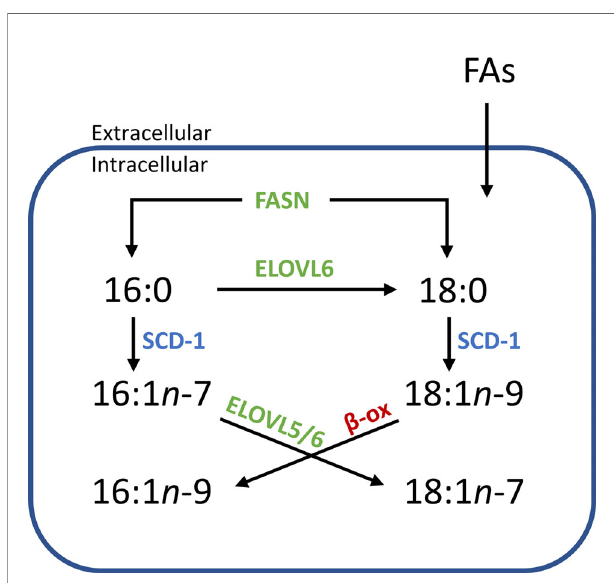
FIGURE 6 | Simpli fi ed fl ow diagram of the origin and fate of fatty acid isomers depending on enzyme interactions. Increased abundance of one isomer over another in distinct tissue regions implies a systematic difference within an aspect of this scheme. e.g. , an increased relative abundance of n -7 isomers might imply that there is an increase of the starting substrate 16:0 (derived from intra/extracellular sources), while increases in n -9 isomers might indicate an increased abundance of 18:0 or an increased expression of ELOVL6. (SCD-1, steroyl- CoA desaturase; ELOVL, elongase enzyme; FASN, fatty acid synthase; b -ox, b